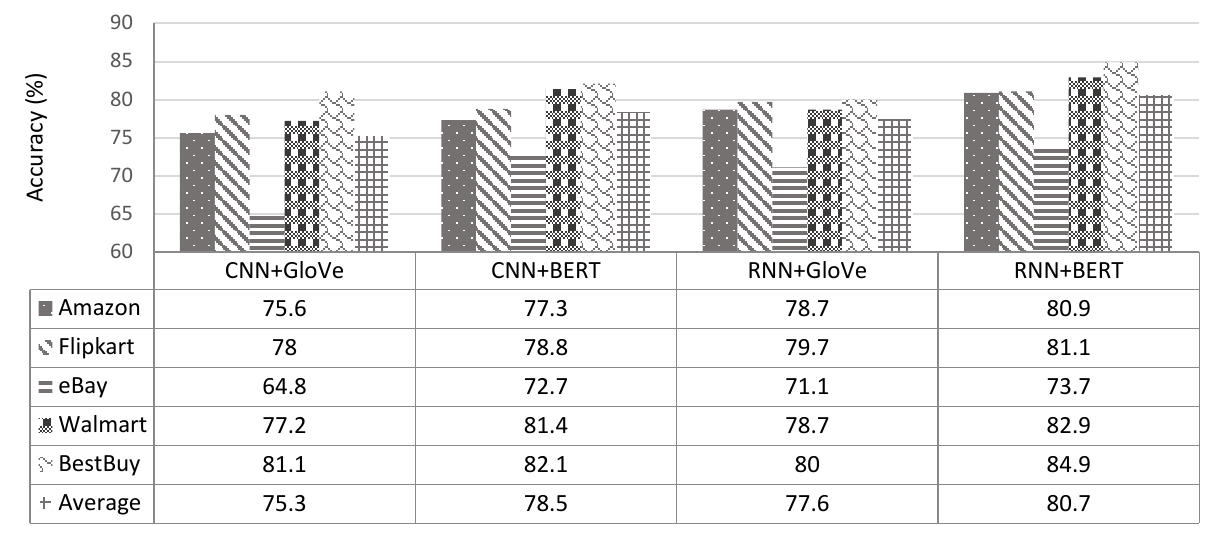
Figure 12. Accuracies from the sampling of different sizes for our dataset. Figure 13. Comparisons of the baseline models for the five research tasks.